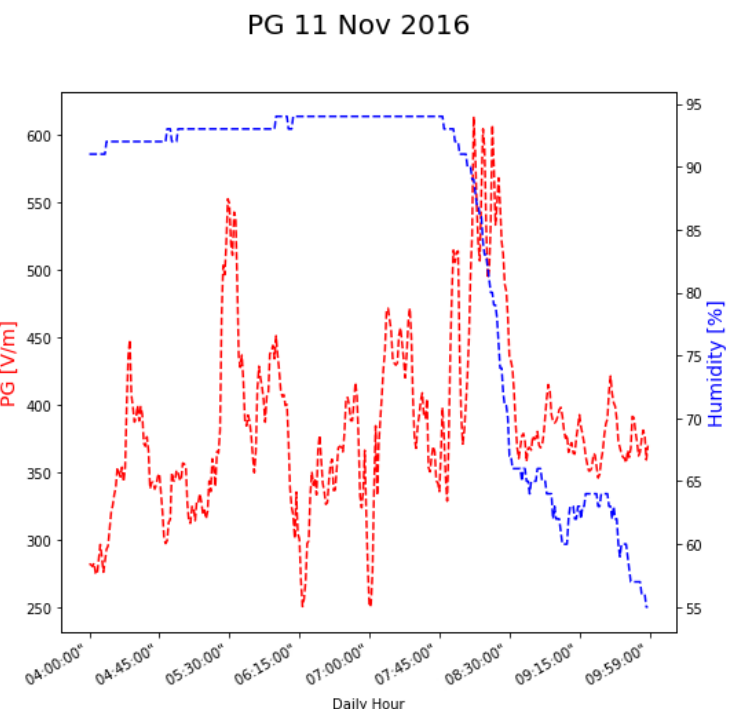
Figure 7. Time dependence of the potential gradient and the relative humidity for the period 04:00–10:00 local time, on 11 November 2016. Note the decrease in PG that precedes the actual dissipation of fog, manifested by the rapid decrease in relative humidity.